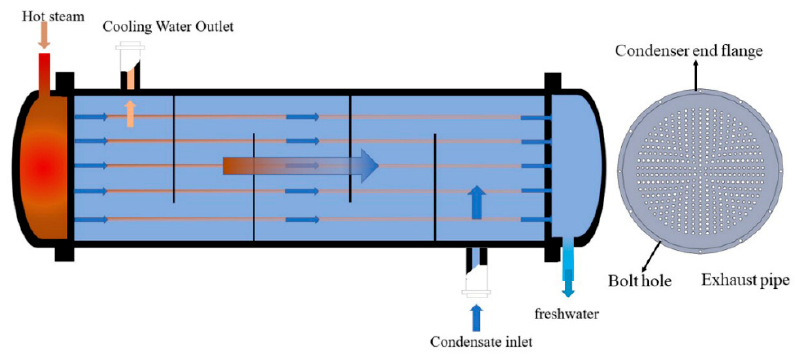
Figure 5. Structural diagram of shell-and-tube circulating condenser.